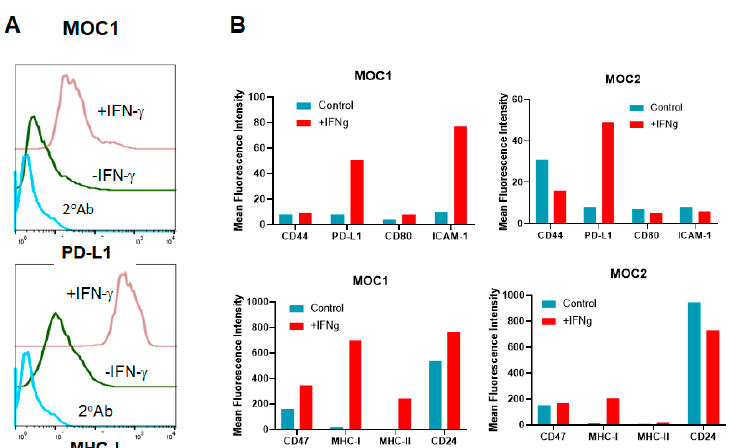
Figure 6. IFN- γ induces MHC class I, PD-L1, ICAM-1, and MHC class II on MOC1 but only MHC class I and PD-L1 on MOC2 cells. Tumor cells (0.5 × 10 6 cells in 3 mL) were cultured in six-well plates with or without 100 ng / mL of IFN- γ for three days. Cells were harvested and stained for surface markers and analyzed by flow cytometry. ( A ) Representative histograms of surface PD-L1 (upper panel) and MHC class I (lower panel) on MOC1 cells. ( B ) Mean Fluorescence Intensity (MFI) of surface markers on MOC1 (left bar graphs) and MOC2 (right bar graphs) is shown. Low intensity markers on the upper panels and high intensity markers on the bottom panels are shown. The MFI is calculated by the flowcytometry as mean value from 10,000 cells. Data represent one of the two